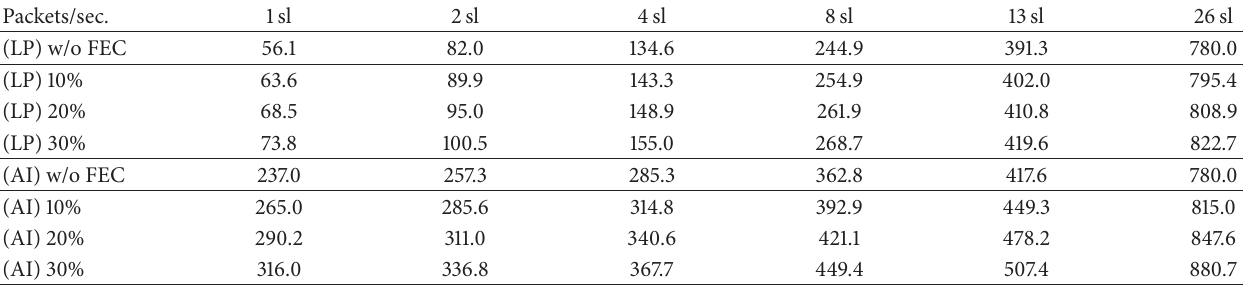
Table 3: Packet rate (packets per second) without FEC protection and with FEC protection for a symbol size of 192 bytes and a protection window of 200 ms for different coding modes, different percentages of redundancy, and different number of slices per frame. Packets/sec. 1sl 2sl